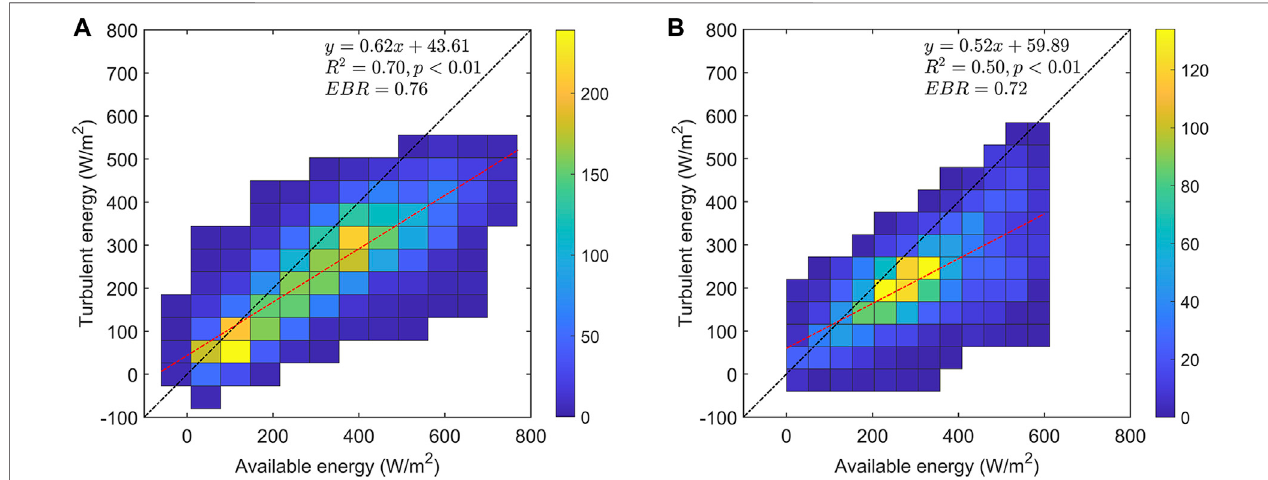
FIGURE4| Resultsofenergybalanceanalysisinthe (A) westand (B) east.Theblackdotlineistheidealclosurecondition,andthereddotlineistheenergyclosure degree obtained by OLS. The color bars represent the count of EBR value.